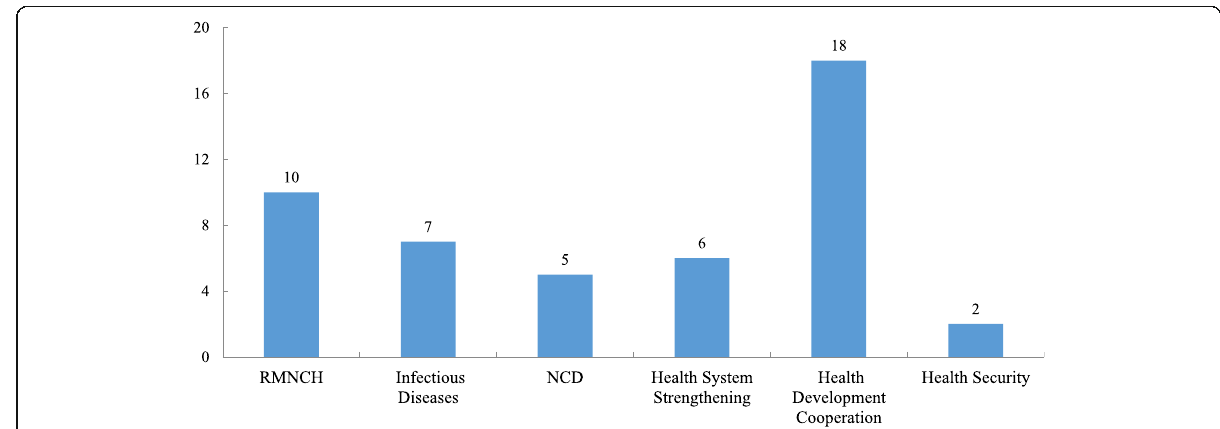
Fig. 6 Topic distribution of GHSP policy briefings. Data source: GHSP project completion report from PMO, Mar